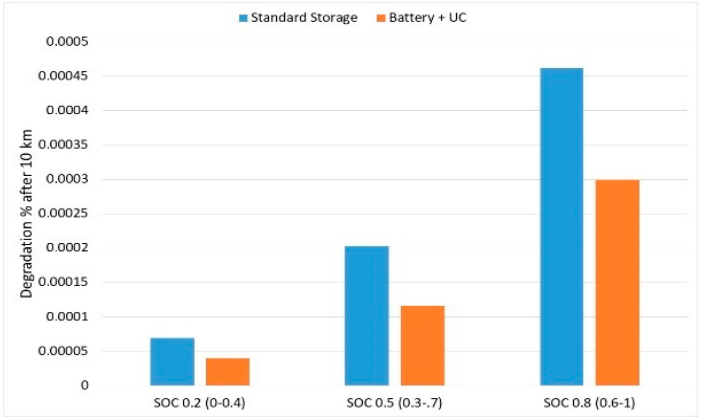
Figure 19. Differences between the standard storage and battery with UCs for the WLTC Class1 with Figure 19. Di ff erences between the standard storage and battery with UCs for the WLTC Class 1 with different SOCs. di ff erent